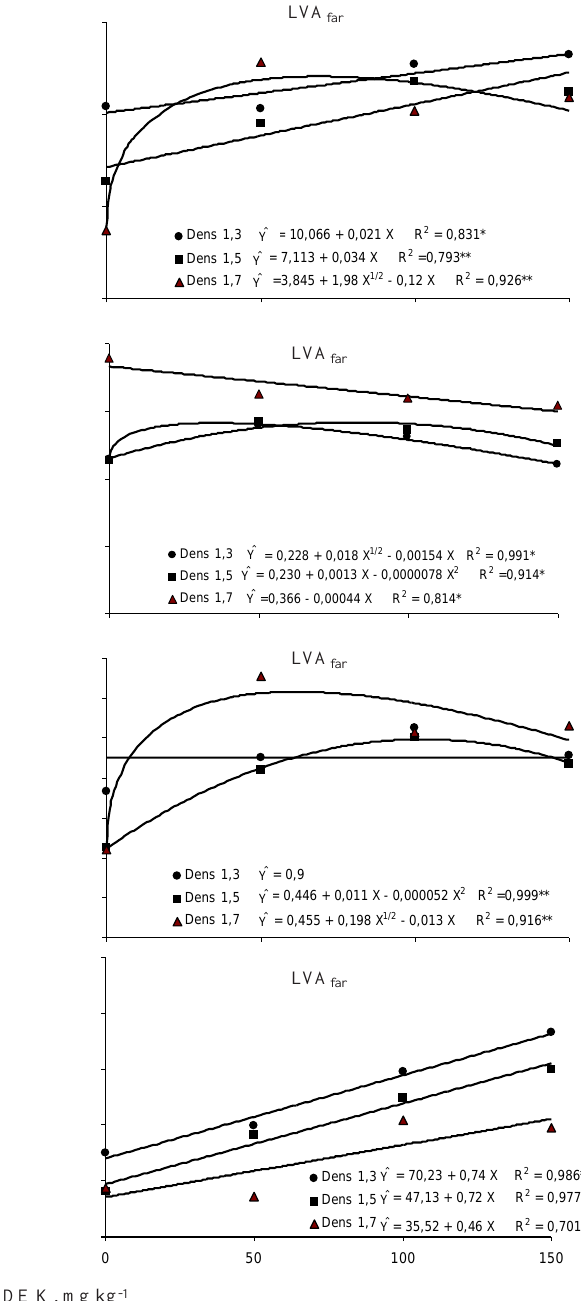
Figura 3. Densidade, diâmetro e superfície radiculares e razão de eficiência radicular de K de plantas de E. camaldulensis , cultivadas em dois Latossolos de texturas muito argilosa (LV (LVA ), com diferentes densidades e doses de potássio. far